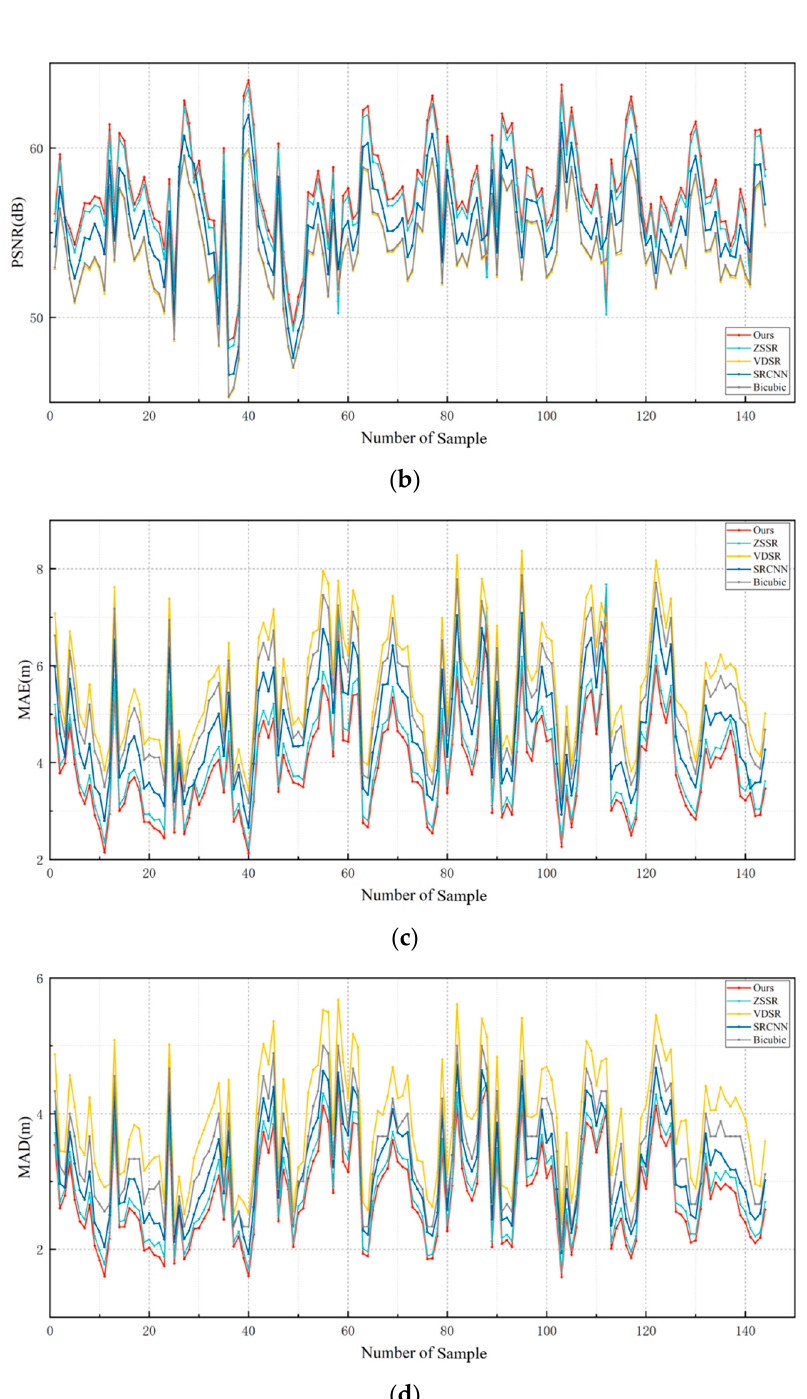
Figure 11. Quantitative results for the test area outside the training area: ( a ) RMSE value of the test area; ( b ) PSNR value of the test area; ( c ) MAE value of the test area; ( d ) MAD value of the test area.